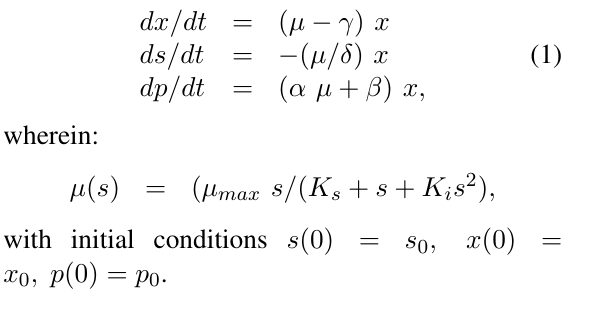
Fig. 3. Solution of model (1), 600